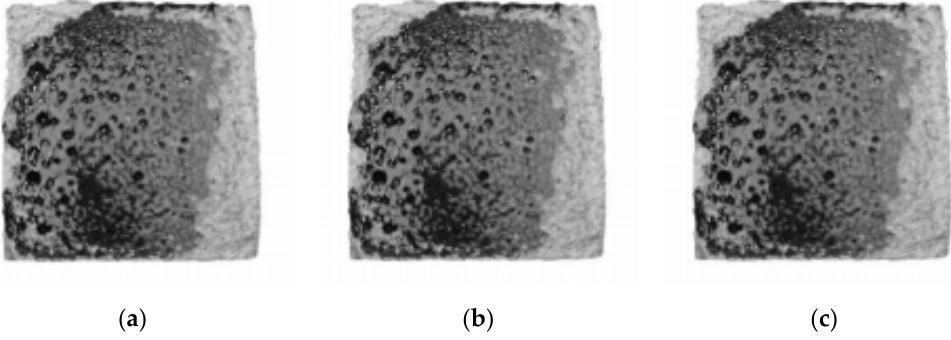
Figure 9. Image preprocessing, ( a ) Gray processing, ( b ) Wiener filtering, ( c ) Median filtering. Next, we used image grayscale and threshold selection, using MATLAB 2018 soft- ware to analyze and process the digital images to show the fracture surface. The second- developed program, as well as the original software, were used to analyze and process the pixels in the images. A grayscale image was regarded as a two-dimensional function of f (x, y), where (x, y) represented the spatial plane coordinates, and the function value f represented image brightness, which was termed “gray”, to express the brightness of each image. Each (x, y) coordinate point in the image corresponded to a gray value, and image information and gray values for all the coordinate points in the image were used to form a digital image. This was denoted as a digitization of the coordinate values by sampling, and the digitization of the gray values was denoted by quantization. The gray values for each coordinate point were divided into 266 small divisions, ranging from pure black to pure white, and were represented by values ranging from 0 to 255, where 0 indicated pure black and 255 indicated pure white. When taking a photo, the gray value displayed on the picture was different because of varying luminous flux, which was reflected by the different materials. On this basis, we analyzed the gray values on the coordinate point to determine the composition and area ratio of the materials in the photos. Non-linear, linear, and piecewise linear transformations were the most-used gray-scale transformation